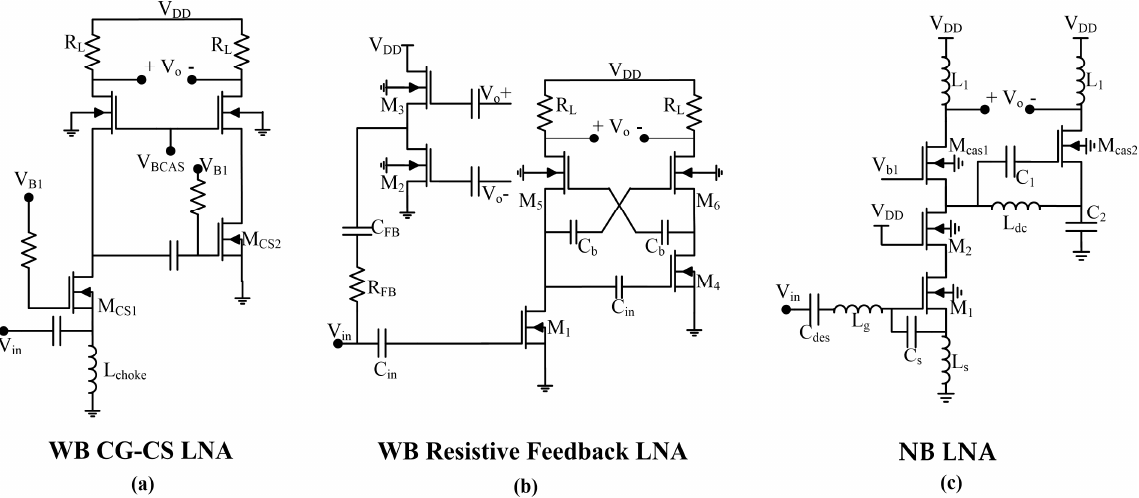
Figure 5. LNAs designed in this work: ( a ) WB-CG-CS LNA [22]; ( b ) WB resistive feedback LNA [23]. ( c ) NB-LNA (modified architecture from [24]) (Bias not shown for clarity).